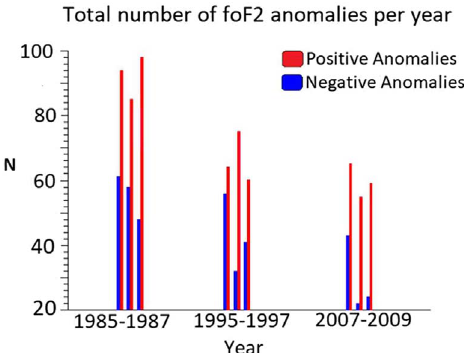
Fig. 1. Total number of positive and negative foF2 anomalies, with a minimum duration of 1 h, observed per year at the Rome